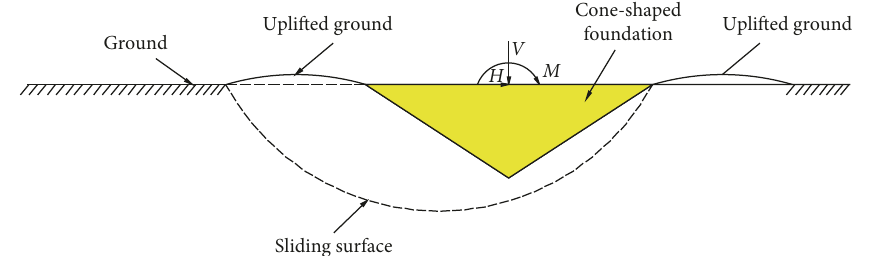
Figure 13: Failure mechanism for cone-shaped